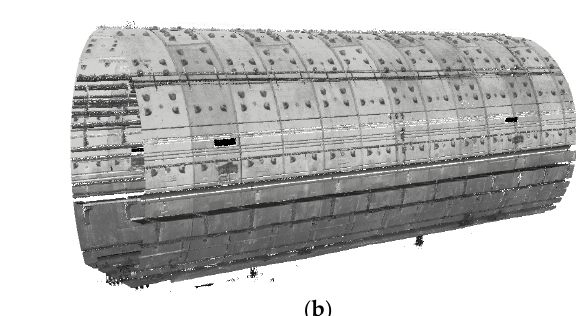
( b ) Figure 11. Positioning effect of a shield tunnel in the ( a ) expanded state and ( b ) original state. 3. Results A circular shield tunnel section of the Tianjin operating subway was selected to verify the effectiveness of the proposed method. The starting mileage of the specific survey area was K19 + 143, length was approximately 100 m, ring width was 1.2 m, inner diameter of tunnel lining was 5.5 m, lining was constructed of precast reinforced concrete segments, and segment splicing method was staggered splicing. The point cloud data from the shield tunnel were collected using the mobile tunnel measurement system developed by Capital Normal University. It consists of an electric inspection vehicle, Z+F 9012 scanner and its battery, laptop computer (or industrial tablet), and acquisition control software. The ac- quisition control software is deployed on the laptop (or industrial tablet) and connected to the scanner through a local area network. The Z+F 9012 scanner has three types of resolution (low, high, and ultra-high) and three rotational speeds (50, 100, and 200 Hz). The scanner can simultaneously collect co- ordinates and laser reflectivity information, and its technical parameters are summarized in Table 2. The electric inspection vehicle can be driven at a constant speed of 0.05–1.25 m/s and adjusted through five gears. The constant speed error is less than 0.5%. The mo-